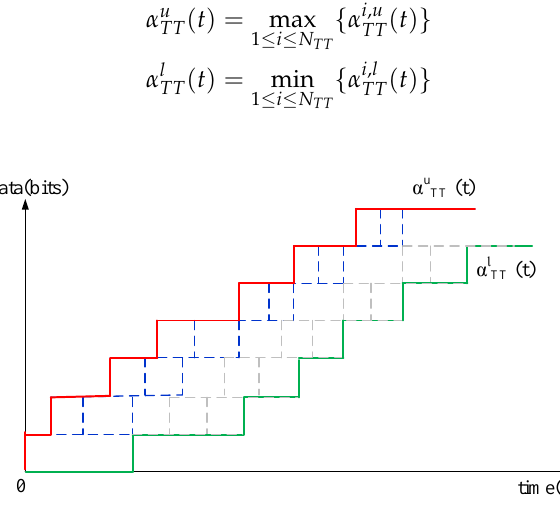
Figure 5. Aggregate arrival curve of TT